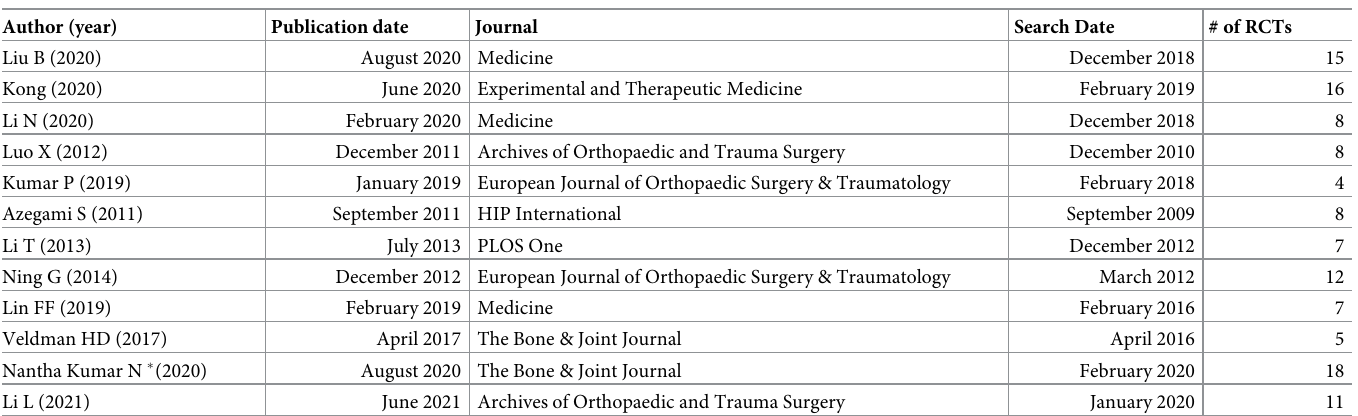
Table 1. Characteristics.